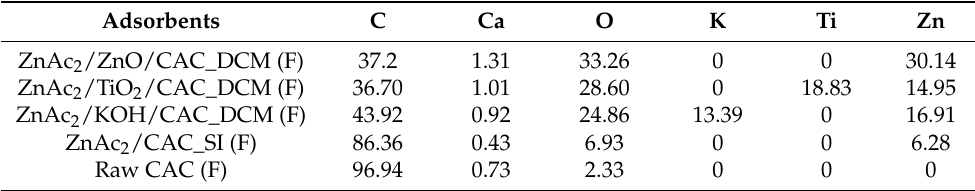
Table 1. EDX analysis results for fresh adsorbents.